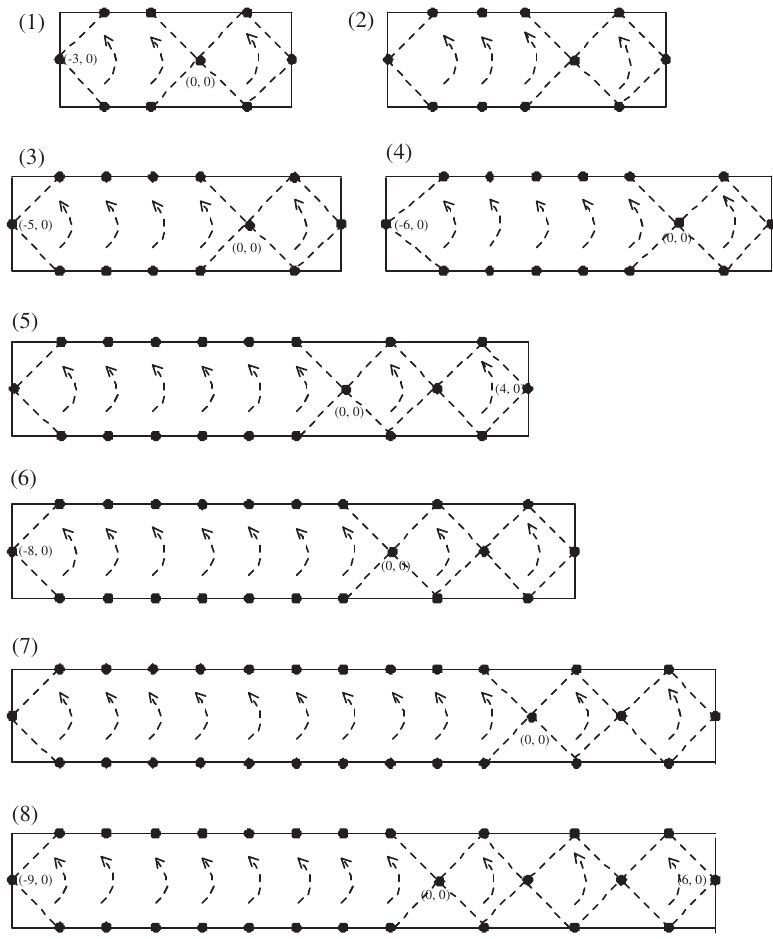
∨ C 2,4 ) = [ 0,9 ] Z ; (2) F ( C 2,8 8 8